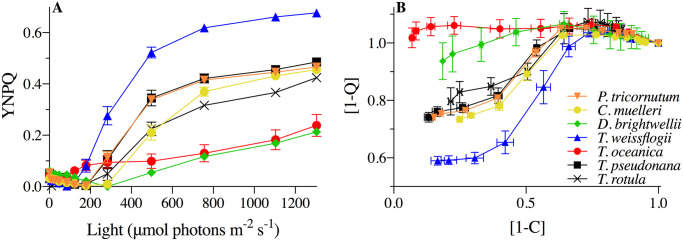
Initial photophysiological monitoring of seven diatoms: Phaeodactylum tricornutum (orange inverted triangles), Chaetoceros muelleri (yellow circles), Ditylum brightwellii (green diamonds), Thalassiosira rotula (black Xs), Thalassiosira pseudonana (black squares), Thalassiosira weissflogii (blue triangles), and Thalassisosira oceanica (red circles).(A) Yield of non-photochemical quenching (YNPQ; see Eq 3) with increasing light intensity. (B) Dynamic non-photochemical quenching [1-Q] versus photochemical [1-C], where data points signify responses to stepped increases in light intensity starting from 0 (far right point) to 1304 μmol photons m-2 s-1 (far left point) for 4 min at each light intensity. Error bars represent the standard error of the mean of at least n = 3 for independent biological replicates.